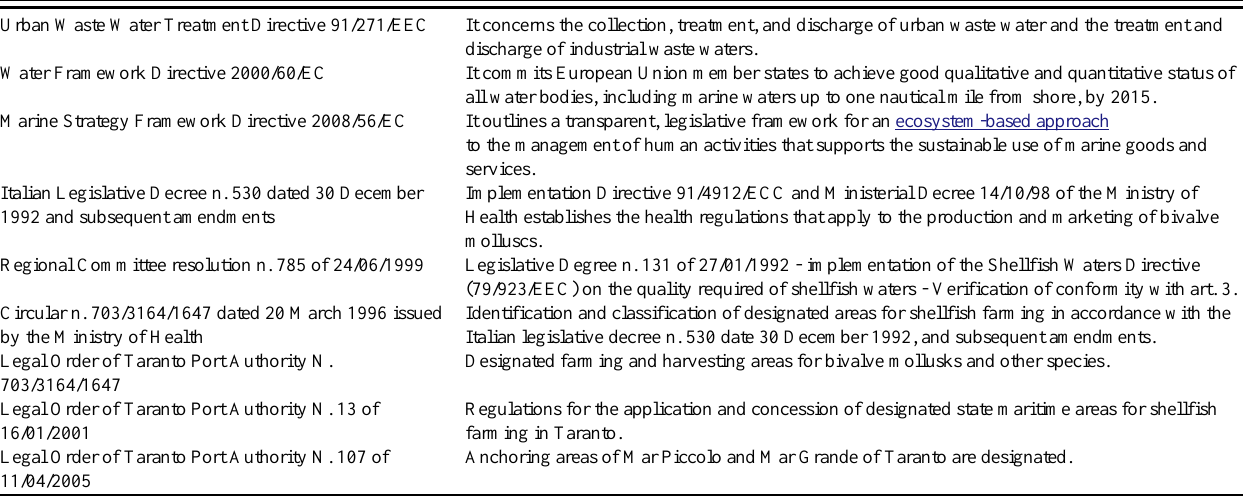
Table 1 . European, Italian, and regional legislation regulating mussel culture in Taranto. Urban Waste Water Treatment Directive 91/271/EEC Water Framework Directive